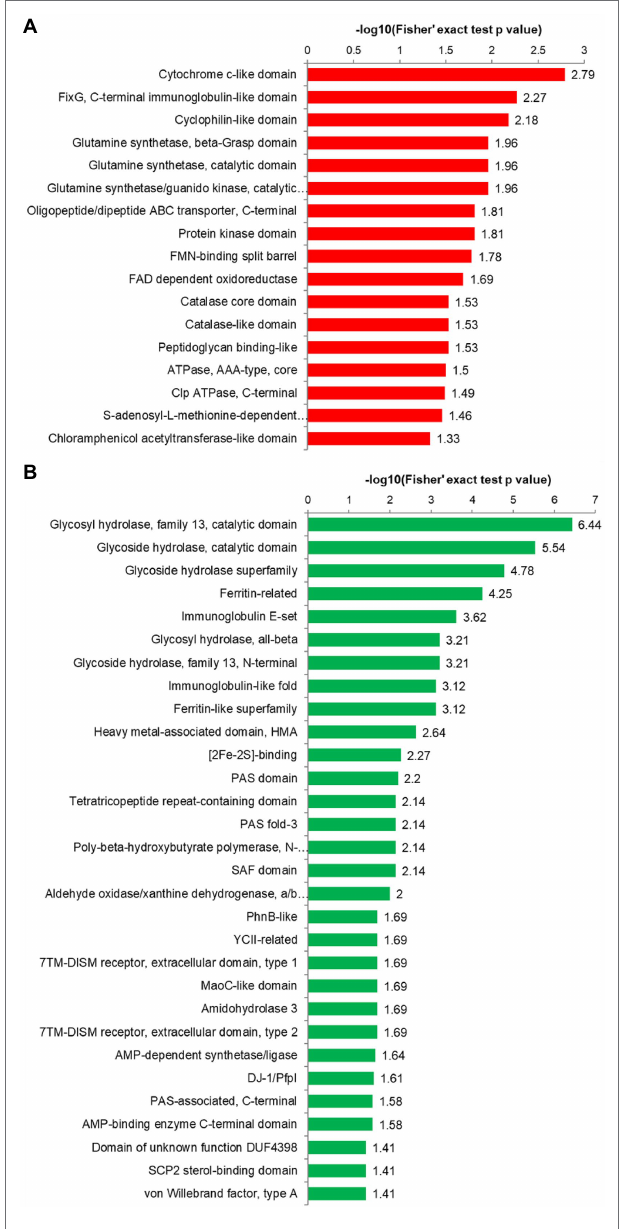
FIGURE 6 | Protein domain enrichment analysis. (A) Protein domain enrichment results of upregulated proteins. (B) Protein domain enrichment results of downregulated proteins. The y axis denotes the categories of the protein domain. The x axis denotes the enrichment score [ − log(value of p )].